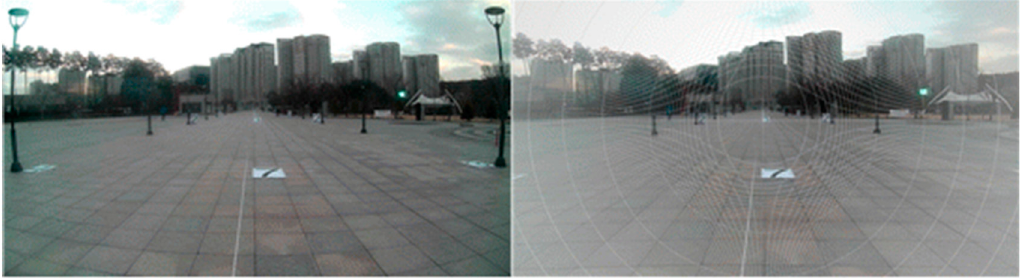
Figure 10. Original image (left) and distortion corrected image (right).